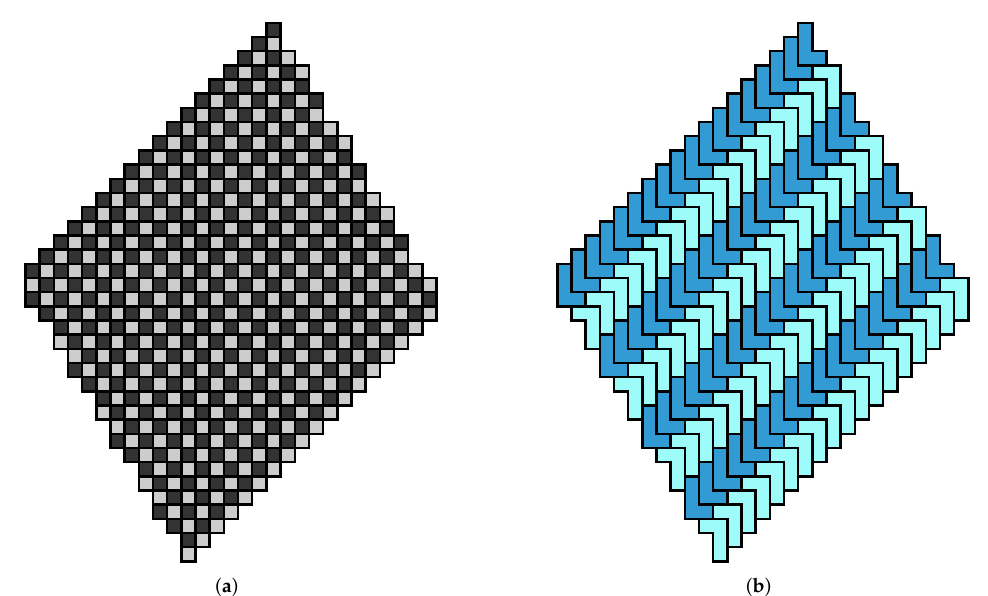
Figure 15. Target region and a tiling solution for Example 3: ( a ) The target region (cid:98) R , a checkerboard coloured irregularly shaped region; ( b ) successful tiling of the target region (cid:98) R using 72 copies of an L-shaped tetromino. The P + variants are coloured light-blue, and the P − 1 corresponding to the single feasible solution of the subproblems when ( a +